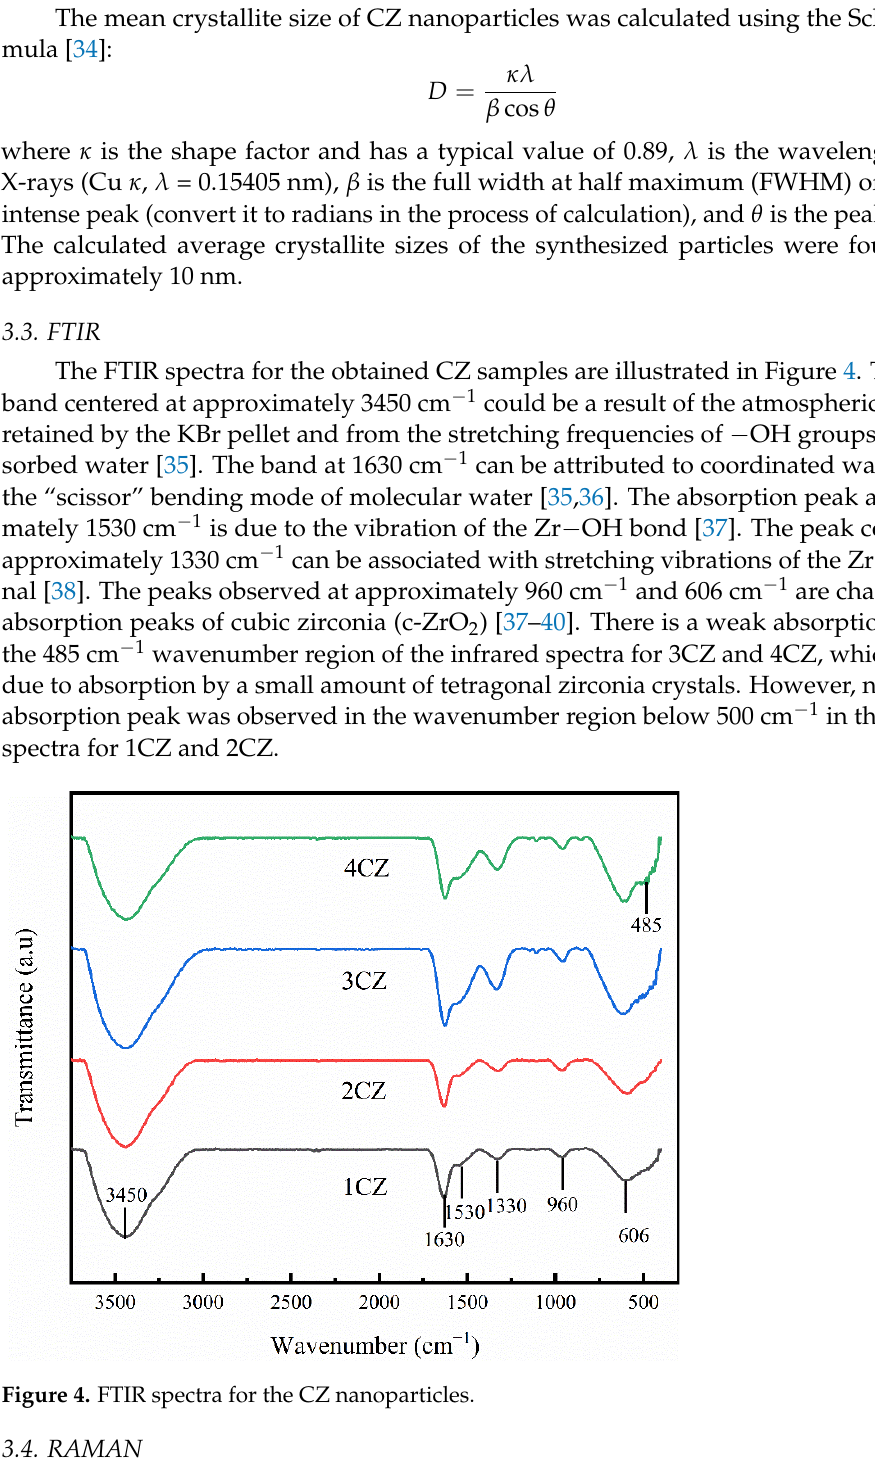
Figure 3. XRD analysis of the CZ nanoparticles.